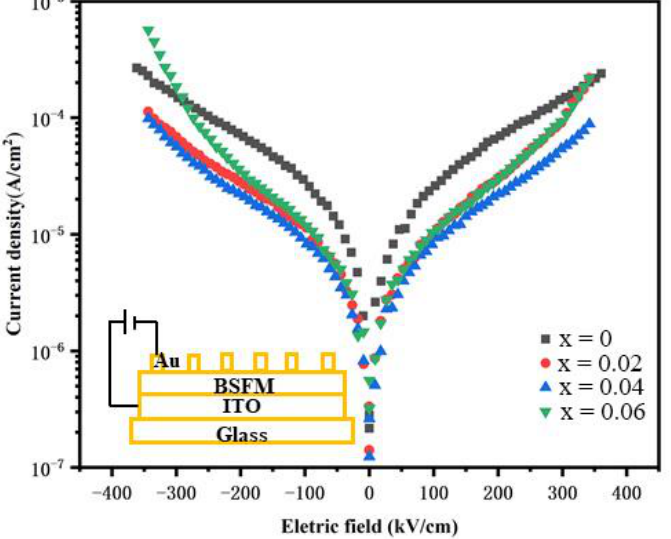
Figure 7. Leakage current density curves of the BSFM films with different Sm content.